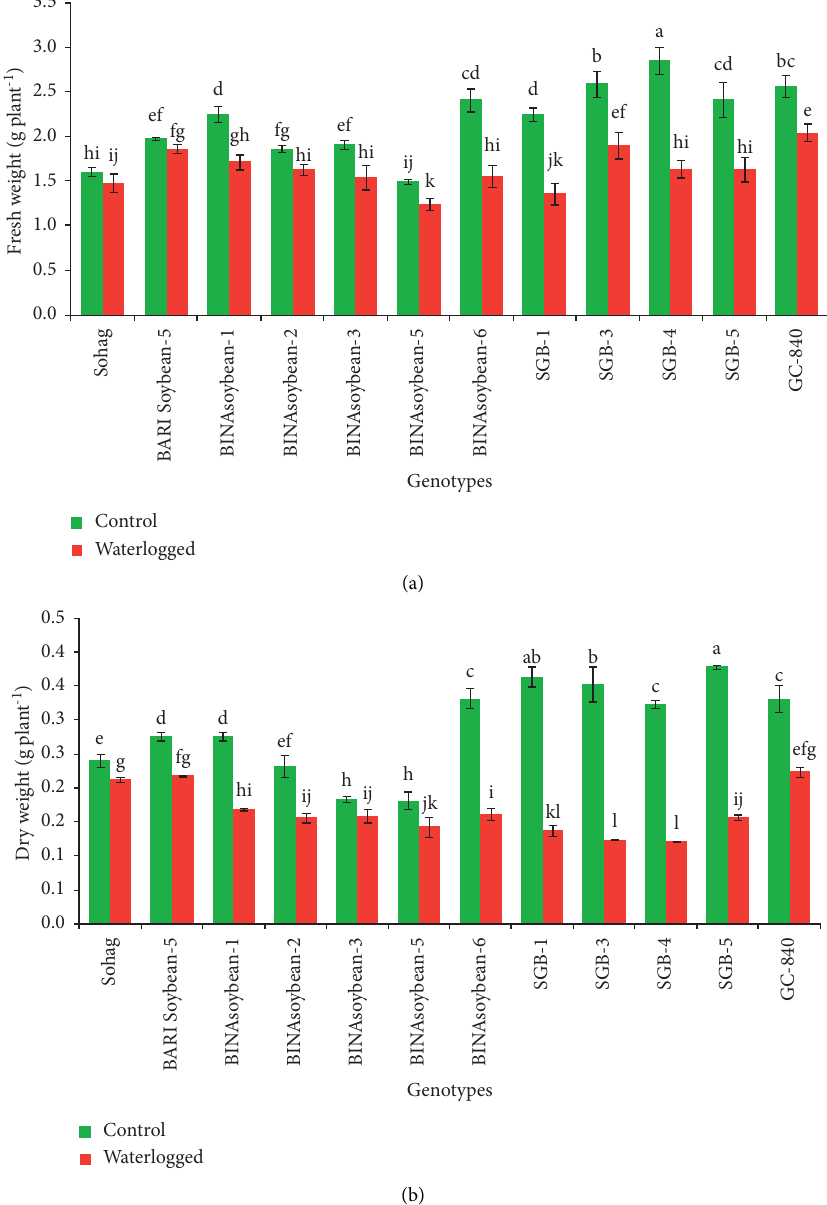
Figure 3: Effect of waterlogging stress on above-ground fresh (a) and dry (b) weight plant − 1 of different soybean genotypes. For each treatment, the mean ( ± SD) was determined from three replicates. Different alphabets on the bars indicate significant difference at P ≤ 0 . 05 after mean comparison by Fisher’s LSD